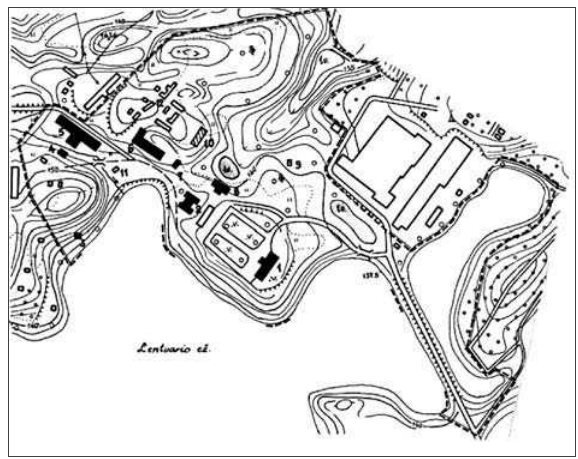
Fig 5. Inventory plan of Lentvaris manor homestead – complex of cultural heritage